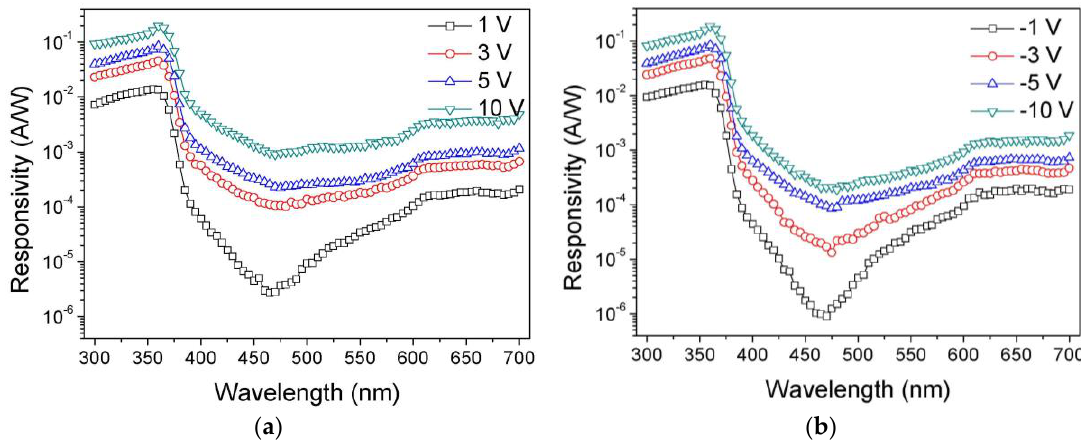
Figure 3. Spectral photo-responsivity characteristics of the fabricated GaN MSM UV photodetector under varying ( a ) forward and ( b ) reverse bias conditions.